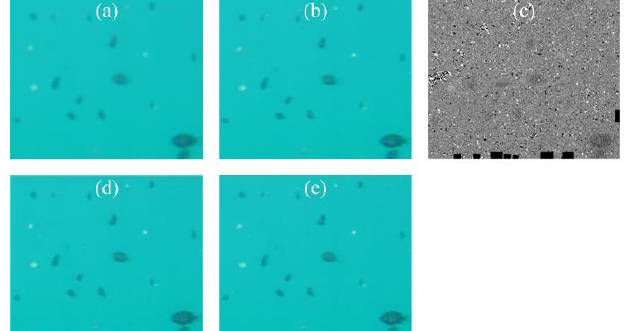
Figure 7. Sample image, restoration and reconstruction results: ( a ) sample image; ( b ) result of M − SB; ( c ) result of M − TV; ( d ) result of PIV − RR; ( e ) result of the proposed method in this paper. Table 6. Comparison of evaluation results.